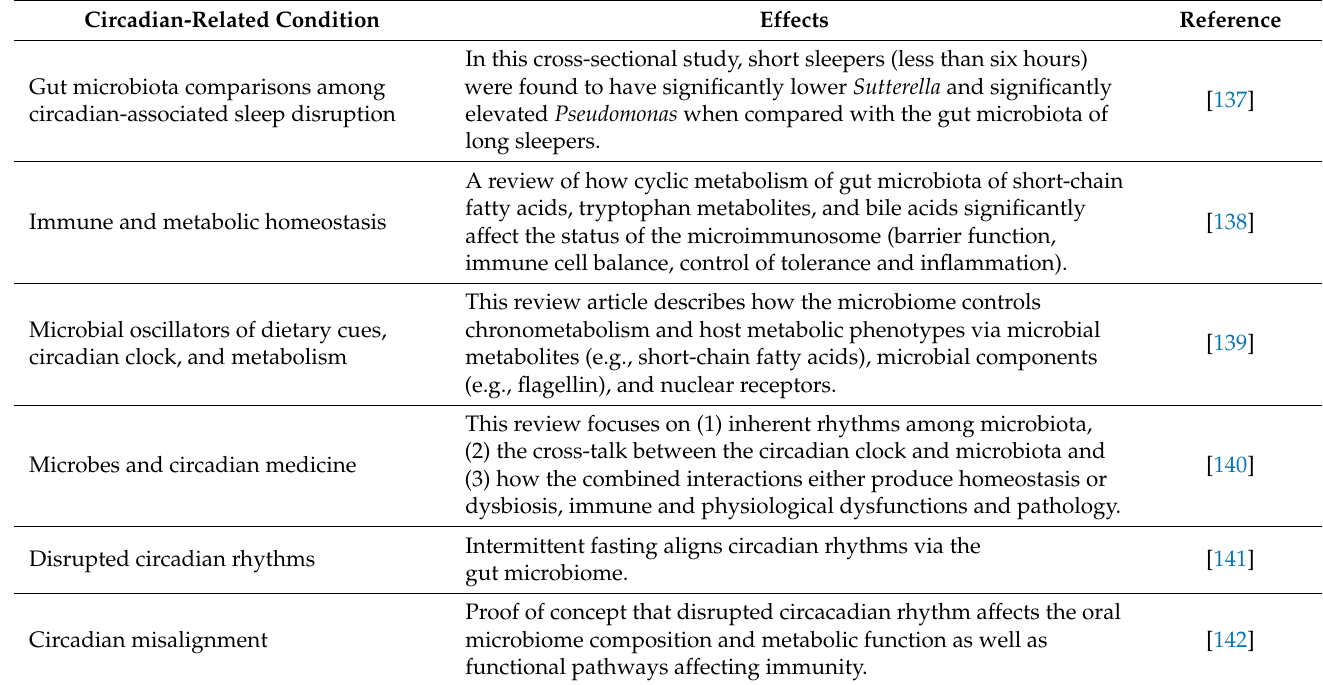
Table 6. Microbiota and Circadian Medicine.